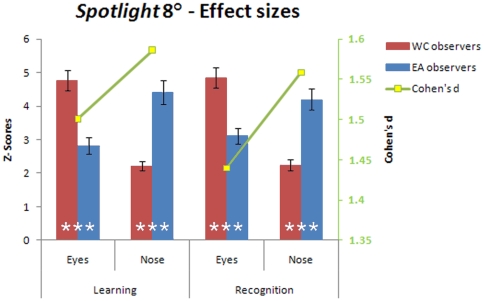
Average Z-score (left y axis) and Cohen's d effect size values (right y axis) for the eye and nose regions during face learning and recognition.WC  =  Western Caucasian; EA  =  East Asian. Error bars report standard errors of the mean. Significant differences between observers from different cultures for each of the facial features are reported at the bottom of the bars (***  = P<.001).